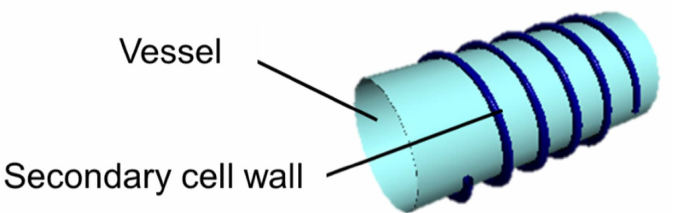
Figure 6. Structure of a